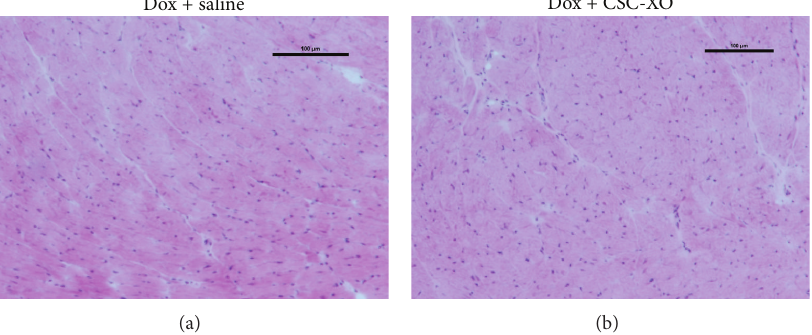
Figure 8: H&E staining of heart sections. Lack of cellular infiltrations indicates no negative immune response by